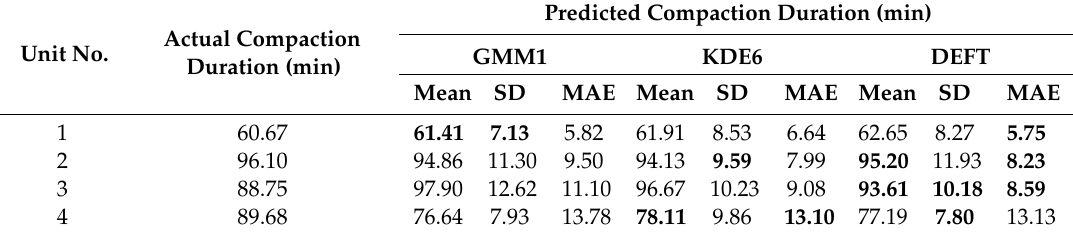
Table 2. Compaction duration results of the simulated layer after replicating the simulation experiment 50 times with improved simulation end condition. Actual Compaction Unit No. Duration